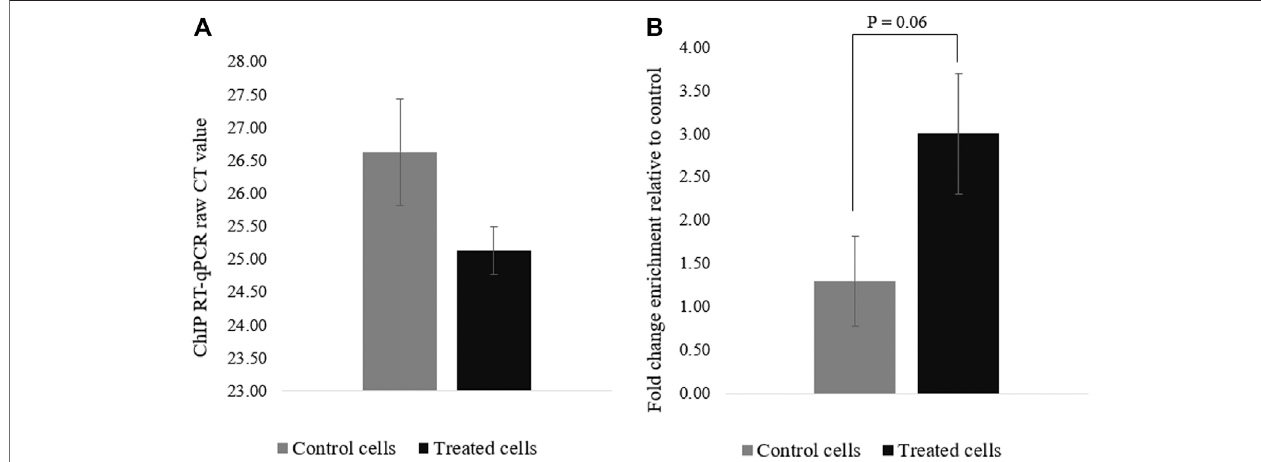
FIGURE 4 | H3K27ac ChIp-qPCR CT values for control and treated cells. (A) Raw CT values were obtained using SYBR green ; (B) Fold change difference (FC = 2 ^ − Δ CT ). Results were obtained from three biological replicates. Error bars represent the standard error of the mean.